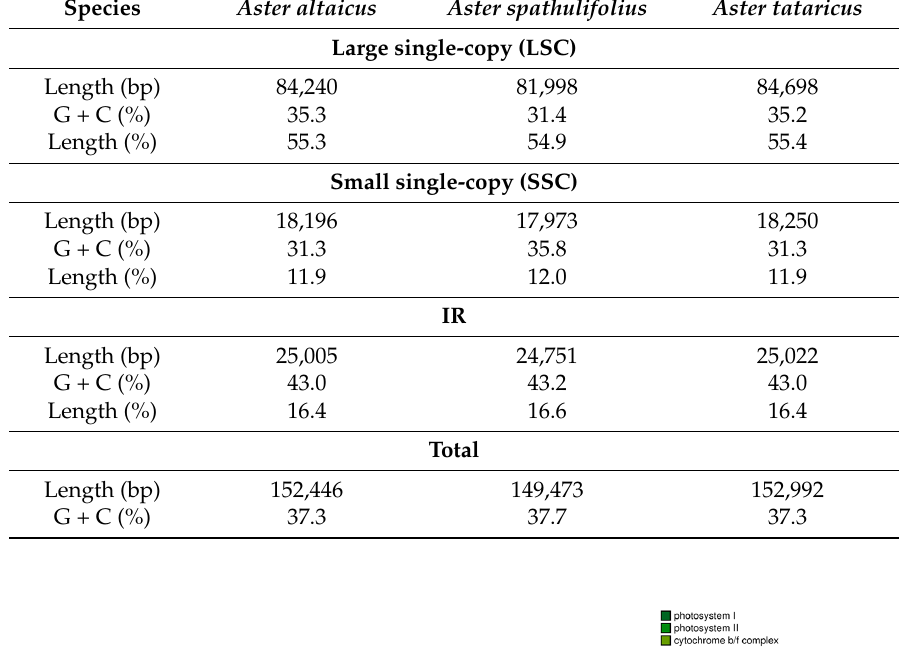
Table 1. Summary of complete chloroplast genomes for three Aster species.